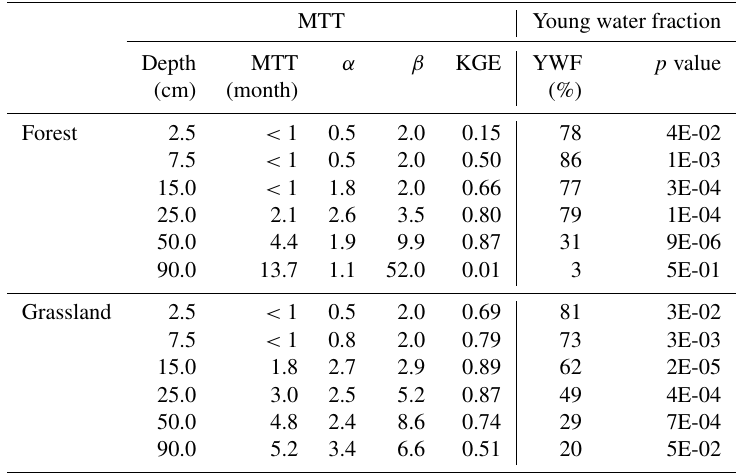
Table 6. Soil bulk water MTT estimates, including their α and β values, from best fits of gamma function and young water fraction (YWF) from the best sine wave fit and associated p